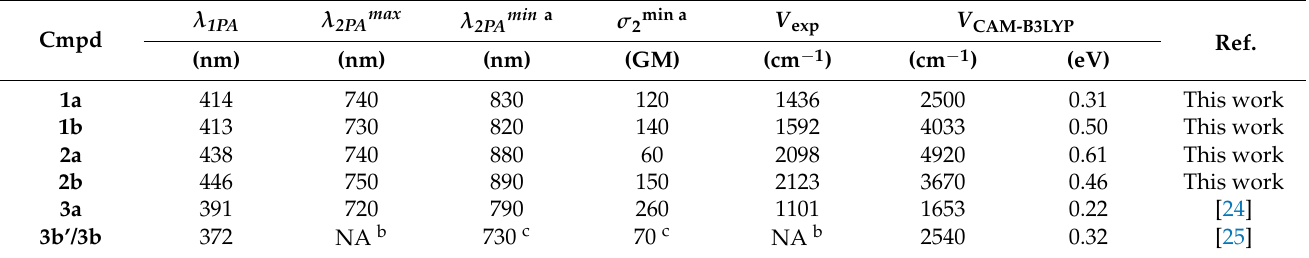
Table 5. Experimental ( V exp ) and CAM-B3LYP-computed ( V CAM-B3LYP ) estimates from the